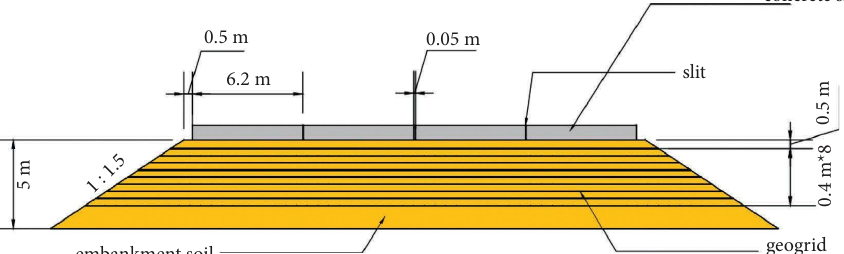
Figure 3: Cross-sectional view of the embankment of the subgrade.